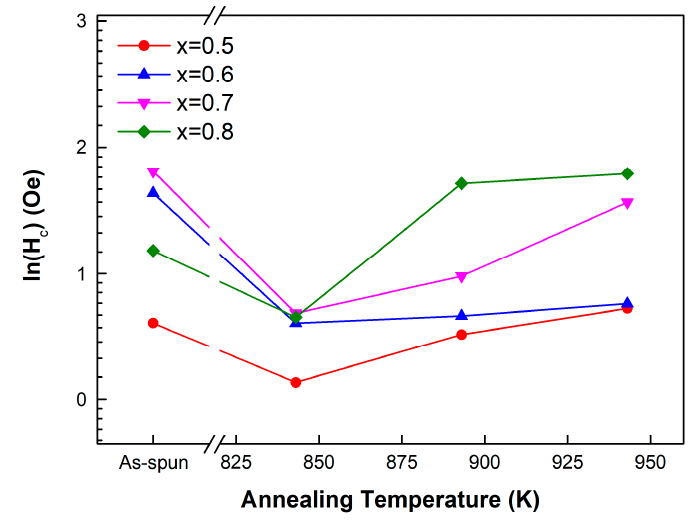
Figure 8. The trend of the coercivity of the (Fe x Co 1 − x ) 72 B 19.2 Si 4.8 Nb 4 (0.5 ≤ x ≤ 0.8, at 0.1 intervals) as-spun and annealed ribbons for 10 min at 843, 893, 943 K, respectively.